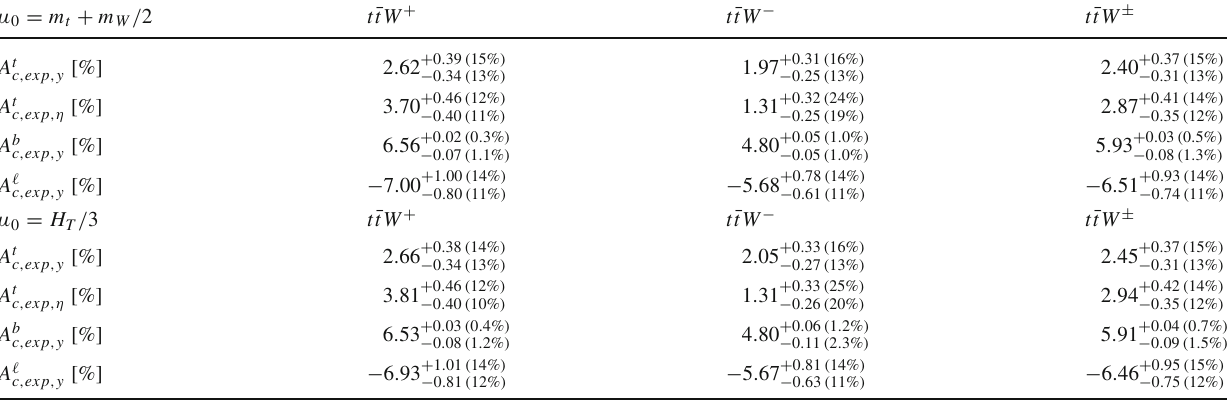
given are combined results for pp → t ¯ tW ± and theoretical uncertain- √ s = 13 ties. The NNPDF3.0 PDF set is employed and μ R = μ F = μ 0 where μ = m + m / 2 and μ = H / t W T 0 0